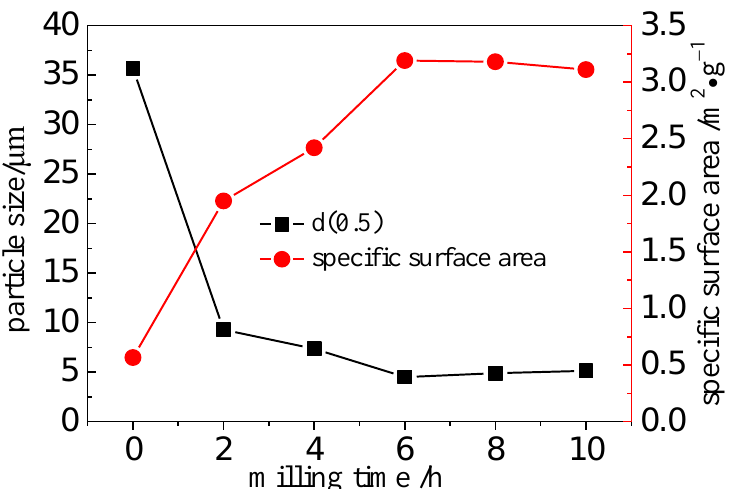
Figure 4. Changes in surface area and particle size with varying milling times.